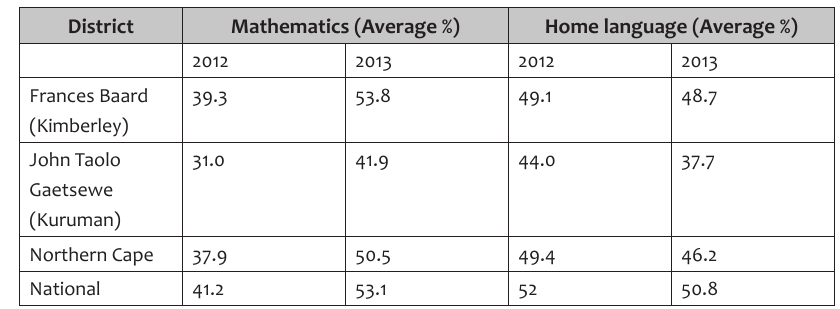
Table 1: 2013 ANA results for Grade 3 in the Frances Baard and John Taolo Gaetsewe districts compared to the provincial and national average (South